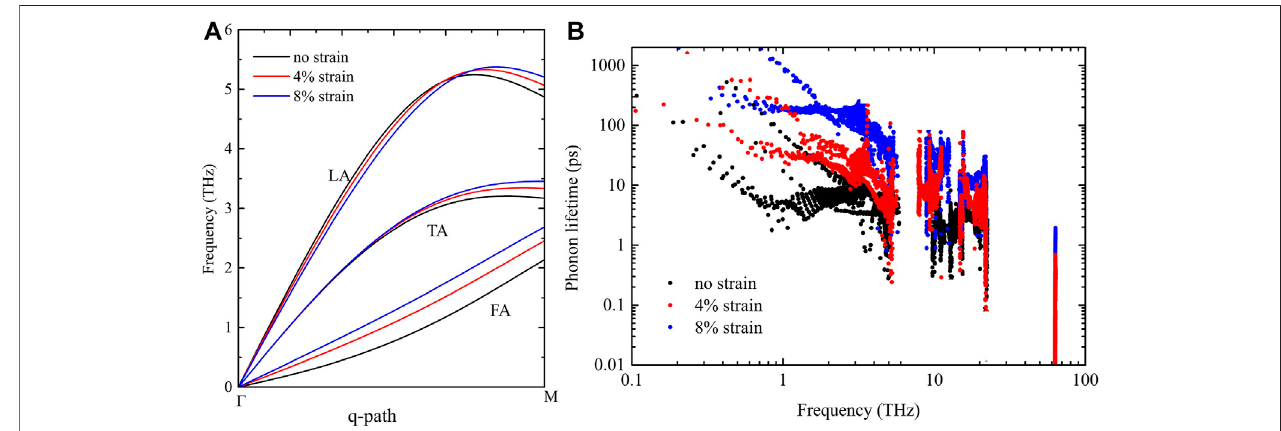
FIGURE 5 | (A) Phonon dispersion curves of acoustic phonon branches of hexagonal H-silicene along the Γ − M direction at typical tensile strains. The three acoustic phonon branches are labeled with FA ( fl exural acoustic), TA (transvers acoustic), and LA (longitudinal acoustic). (B) Frequency-dependent phonon lifetime of hexagonal H-silicene at typical tensile